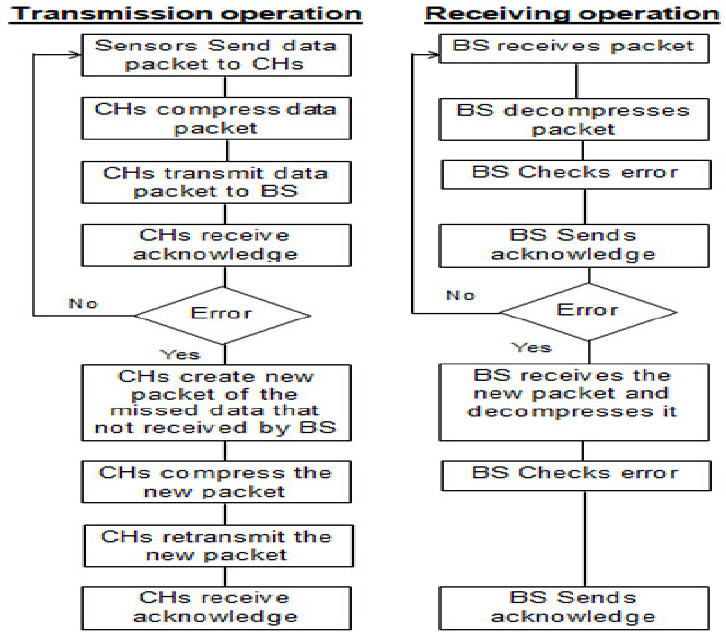
Figure 4. Data communication in case of